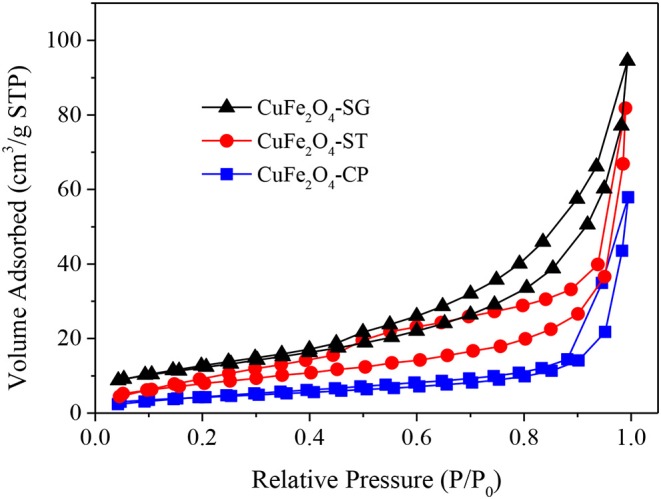
N2 adsorption-desorption isotherms of CuFe2O4 synthesized by different methods.